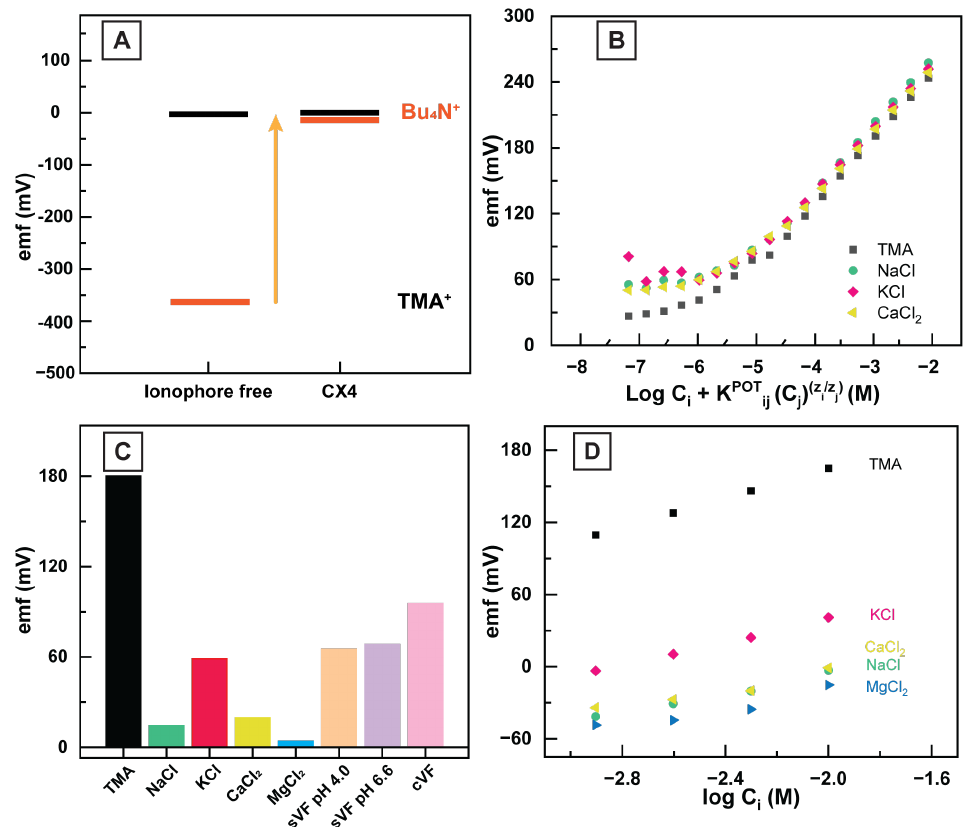
Figure 6. ( A ) The differences in the emf of the HERS for 0.1 mM TMA + solution with respect to 0.1 mM Bu 4 N + upon introducing 10.00 mg/g of CX4 to the sensing membranes. ( B ) FIM calibration: emf response of the HERS electrode in the presence of DI water, 0.1 mM NaCl, 0.1 mM KCl, and 0.1 mM CaCl 2 . ( C ) Measured emf response of the HERS in the solutions containing 10.0 mM TMA, 10.0 mM NaCl, 10.0 mM KCl, 10.0 mM CaCl 2 , 10.0 mM MgCl 2 , sVF (pH = 6.6), sVF (pH = 4.0),